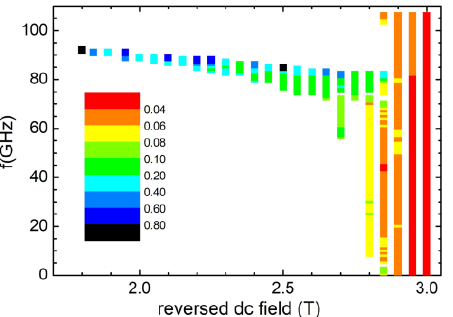
Figure 4. Conditions (exciting frequency vs. applied reversed field) under which reversal occurs within 1 ns for a CoPt disk with diameter 16 nm and thickness 4 nm, covered by a 2 nm Co 3 Pt layer, when the applied field is at 45° to the easy axis. The color code represents the switching time in nanoseconds. A particular color is used for switching time, which is between the values indicated at its two edges.